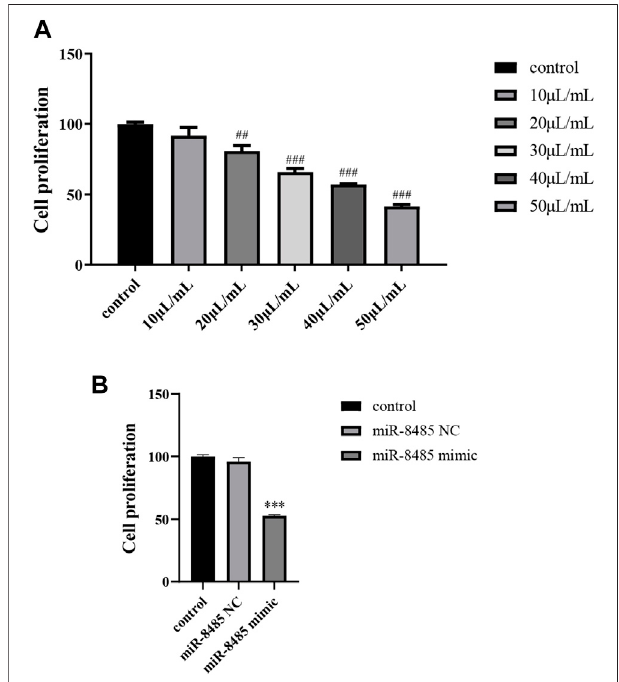
FIGURE 3 | (A) Effects of different concentrations of drugs on cell proliferation; (B) overexpression of miR-8485 on cell proliferation. (All the p values were compared with the control group (n = 3). Data were shown as mean ± SD, ## p < 0.01, ### p < 0.001, *** p <